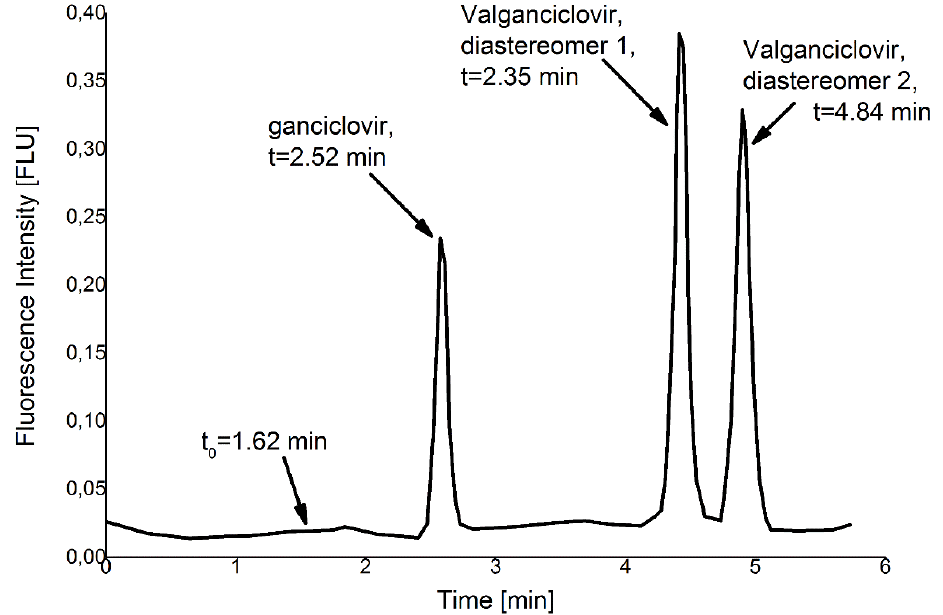
Figure 2. Replotted HPLC chromatogram of valganciclovir normalized with blank. Inj. Volume: 40 µL; ganciclovir is eluted after t(GCV) = 2.52 ± 0.01 min and the two peaks representing the diastereomers of valganciclovir eluted at t(VAL1) = 4.35 ± 0.06 min and t(VAL2) = 4.84 ± 0.06 min. All peaks are separated and allow